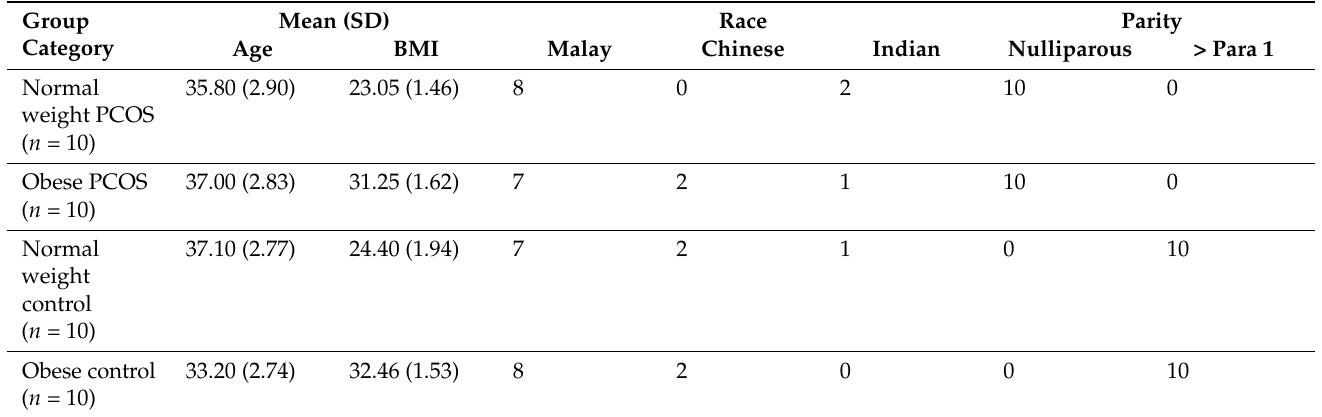
Table 1. The demographic profile of participants according to the study